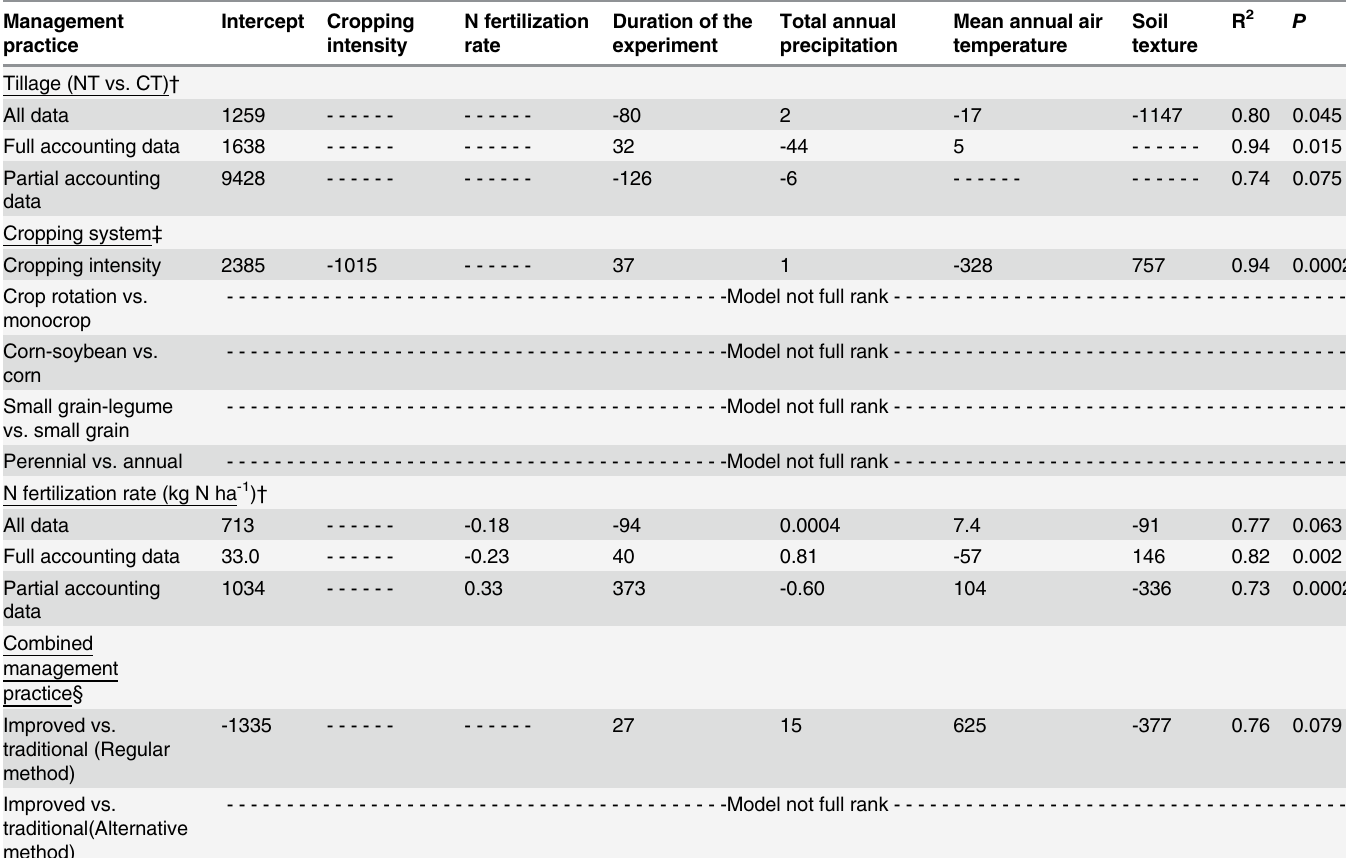
Table 8. Multiple linear regression analysis of net greenhouse gas intensity (GHGI) with management practices, duration of the experiment, total annual precipitation, mean annual air temperature, and soil texture from various